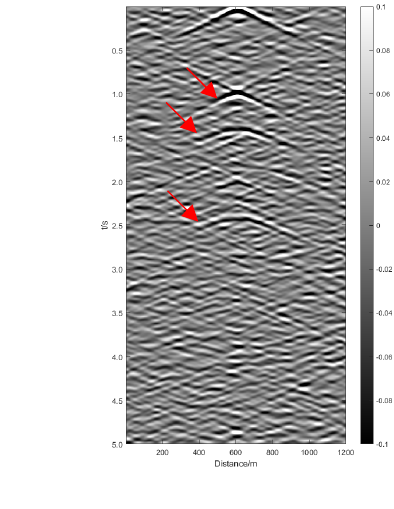
Figure 6. Deep learning network model. The deep learning framework used in our experiment is tensorflow ‐ gpu, version 1.8. The number of epochs is set to 500, the activation function is tanh, and the dropout is